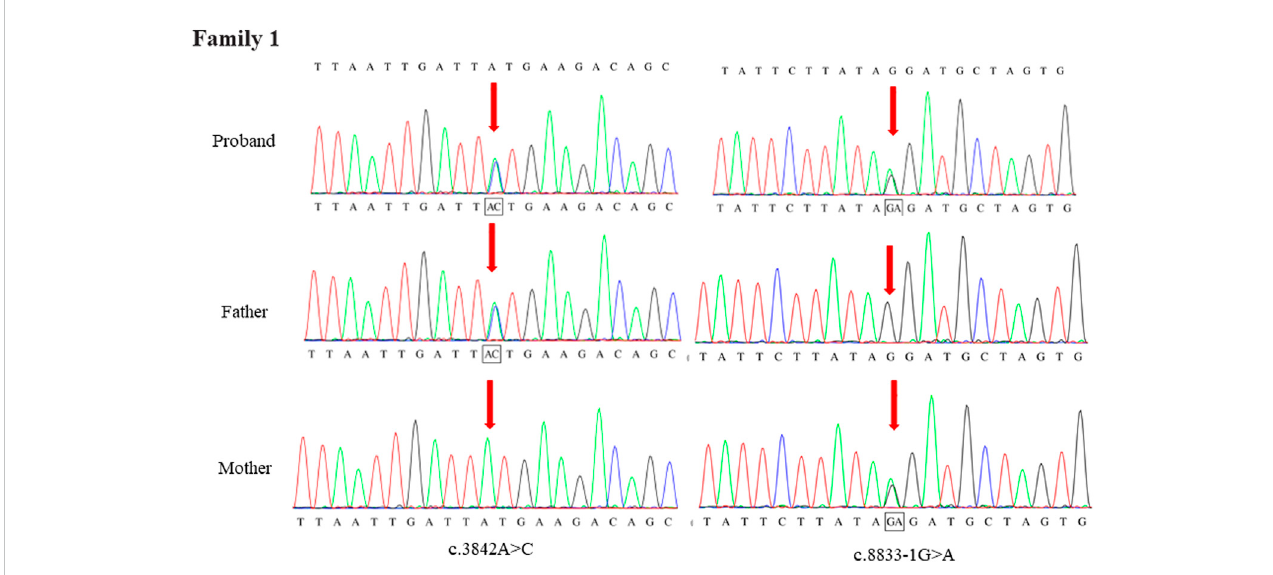
FIGURE 5 Sanger sequence analysis of the mutations of DYNC2H1 gene in the family 1.